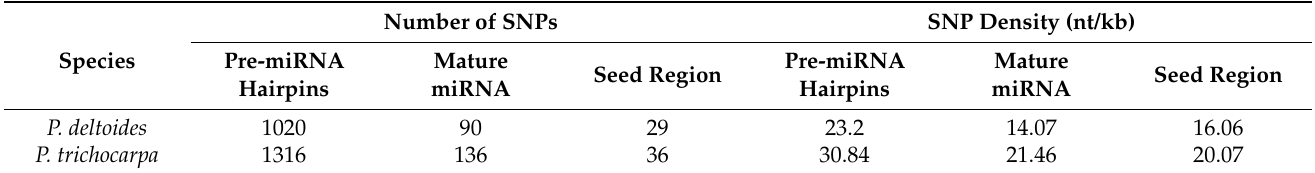
Table 2. miRNA related polymorphisms of P. deltoides and P. trichocarpa